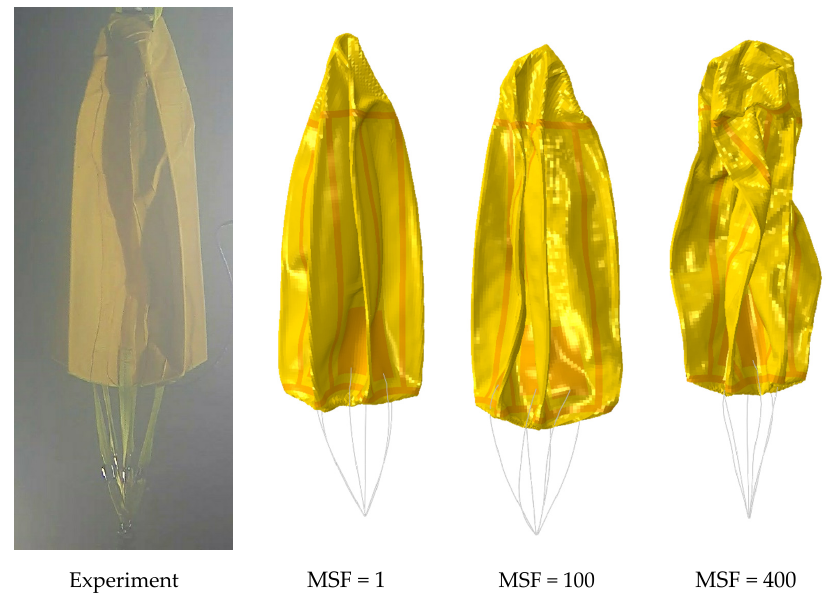
Figure 9. Comparison of the experimental empty shape and numerical shapes with di ff erent